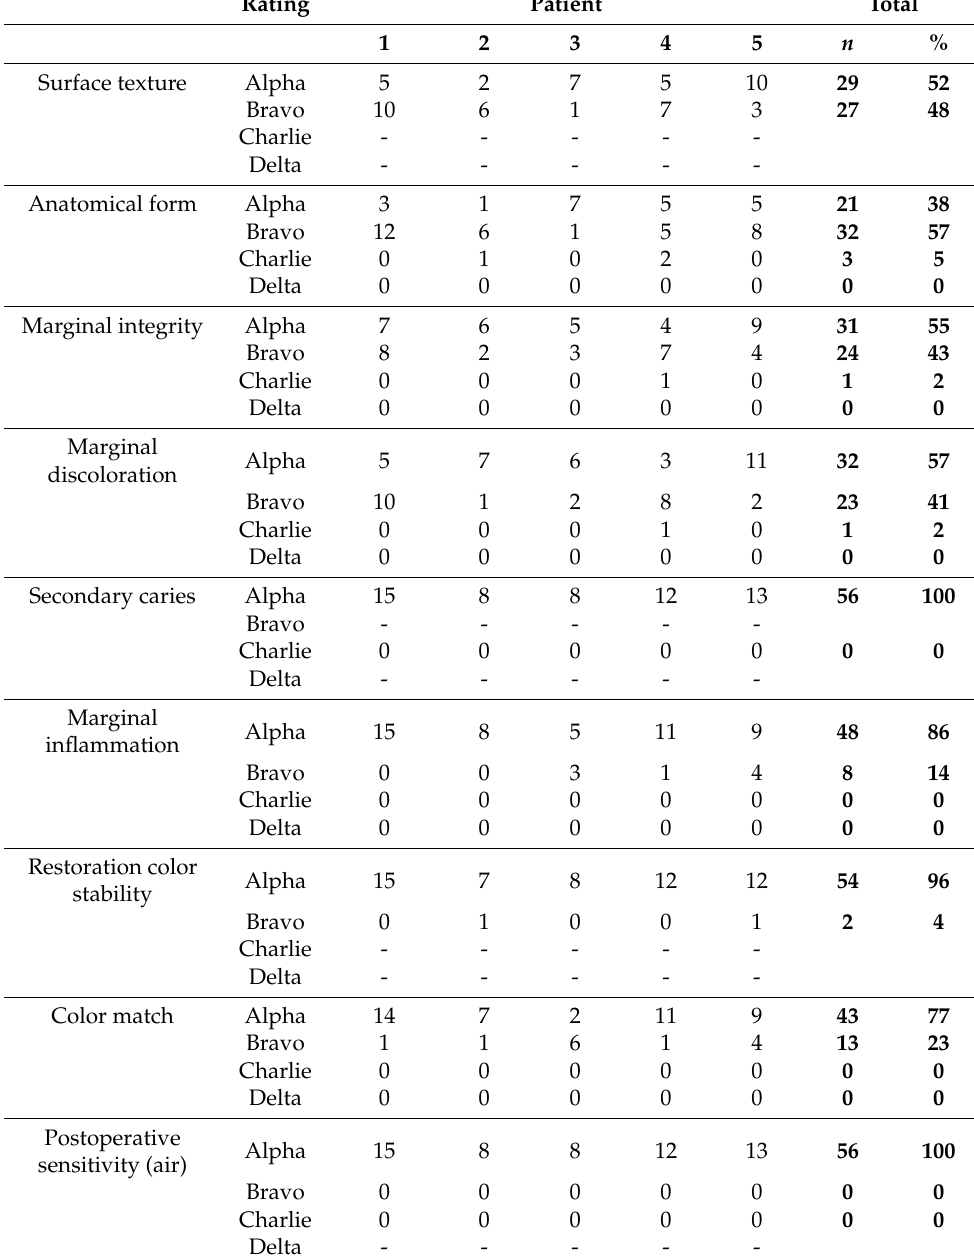
Table 4. Results of the USPHS evaluation of the restorations of the individual patients of the first study cohort still in place at the 10.7-years recall examination (number of restorations is given). The total number of teeth with the respective ratings and the percentages were